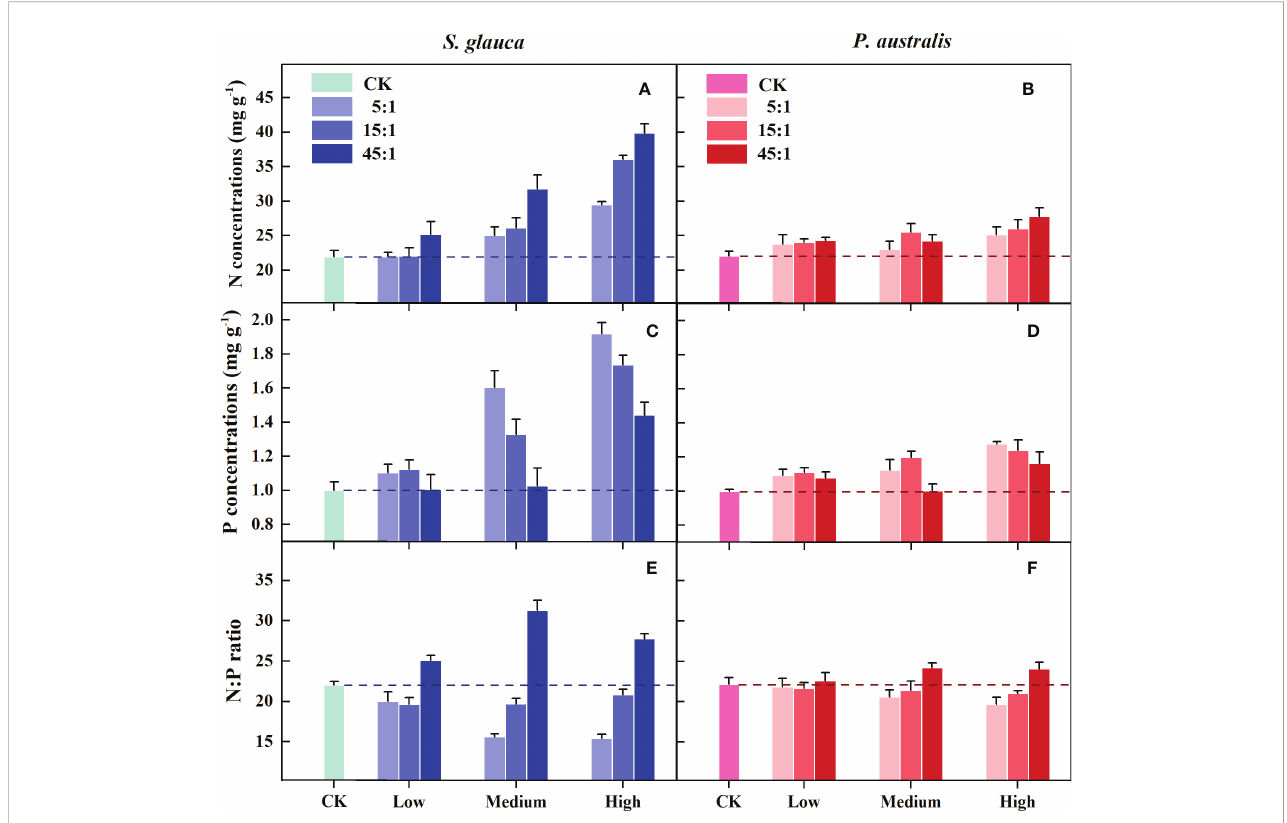
FIGURE 5 Effects of N and P addition on the N (A, B) and P concentrations (C, D) and the N:P ratio (E, F) of S. glauca and P. australis. Different bars indicate the mean value (± SE) for each treatment (N and P addition, n=4; CK, n=6). Green and red indicate positive and negative relationships corrected to red and green indicate positive and negative relationships.